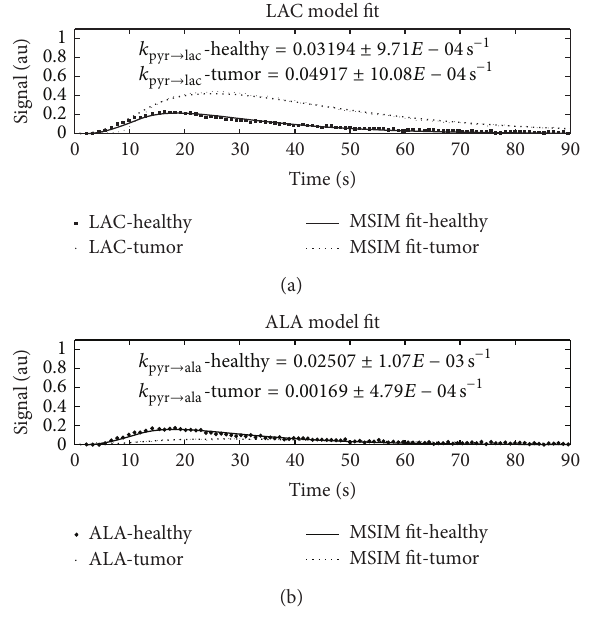
Figure 4: Comparison of 𝑘 between a healthy rat (from an 80 mM dose in kidney predominant tissue) and a rat with mammary